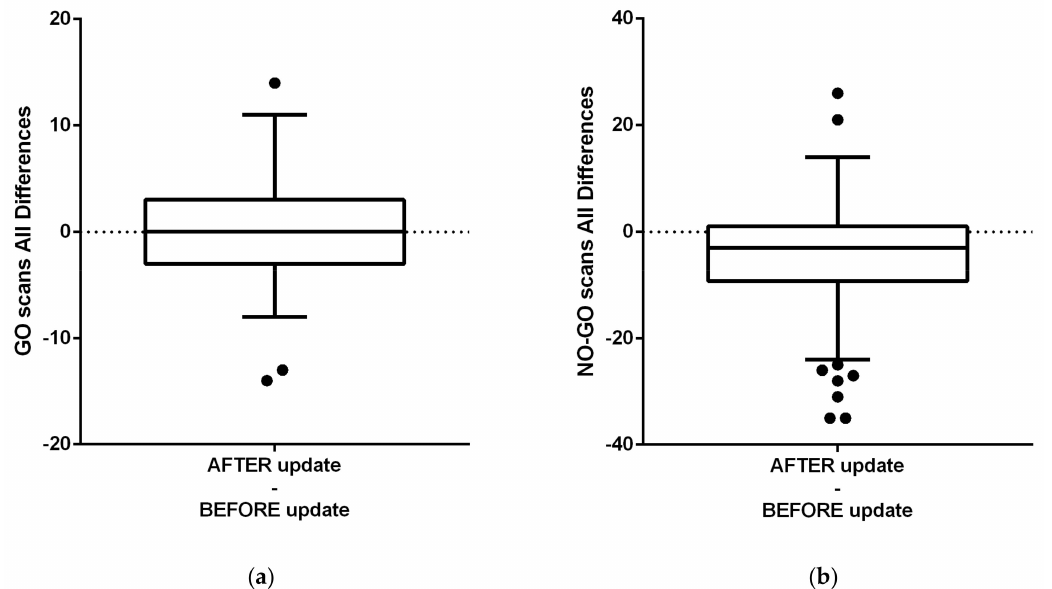
Figure 12. Differences before and after the app update regarding patient clinical performance observed with dental monitoring for all participants. (Paired t test) ( a ) Dental monitoring evaluated GO scans focused on proper aligner tracking, here is not a significant difference. ( b ) Dental monitoring evaluated NO-GO scans focused on proper aligner tracking, here is a significant